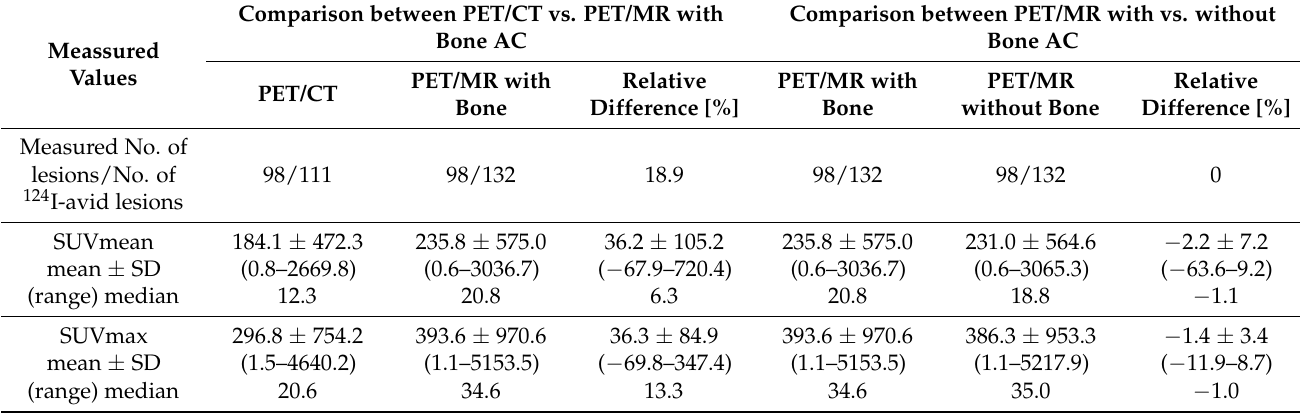
Figure 4. Two patient examples with artifacts in the AC maps based on CT or MR data are shown. The transaxial slice from patient example 1 (head) shows streak and beam hardening artifacts in the CT ‐ based AC due to dental fillings and implants (red arrows). These CT ‐ based AC artifacts may lead to systematic overestimation of PET signal in these regions after applying CT ‐ based AC, while small dental fillings do not cause artifacts in MR ‐ based AC (green arrows). Patient example 2 (thorax) shows MR ‐ based AC artifacts due to metal implants in the sternum resulting in segmentation errors in the Dixon ‐ VIBE AC map (upper red arrow), while the CT ‐ based AC here shows the wire cerclage with its higher signal intensity (HU) but without noticeable artifacts (upper green arrow). Note the additional registration error of the bone atlas in patient example 2 due to segmentation errors in the MR ‐ based AC itself (lower red arrow), while the CT ‐ based AC shows the spine in the correct position (lower green arrow). Table 3. Standardized uptake values (SUV mean and SUV max ) in all measured n = 98 congruent lesions in PET/CT and PET/MR with and without bone atlas in the attenuation correction map (AC map). Relative differences between PET/CT (reference) and PET/MR with bone information, respectively, relative differences between PET/MR with bone (reference), and PET/MR without bone information are